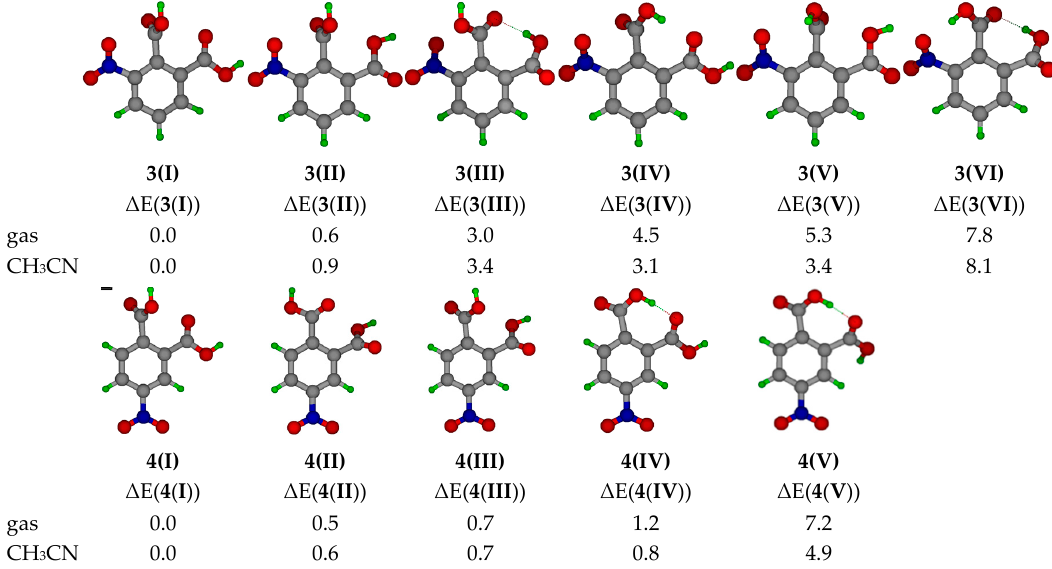
Figure 2. Conformers of monomeric 3 (upper row) and 4 (bottom row) and their relative energies ( Δ E = E min (conformer) – E i (conformer), kcal/mol) obtained at the B3LYP/6-311+G(d,p) level of theory for the gas phase and in acetonitrile (CH 3 CN). E min (conformer) stands for the energy of 3(I) or 4(I). E i (conformer) stands for the energy of the conformer under consideration.